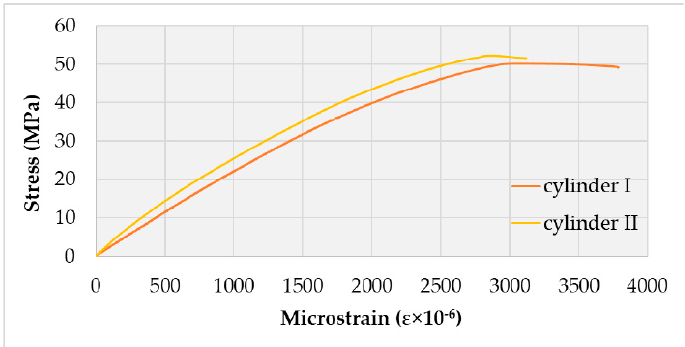
Figure 2. Stress–strain relation for concrete under compression.